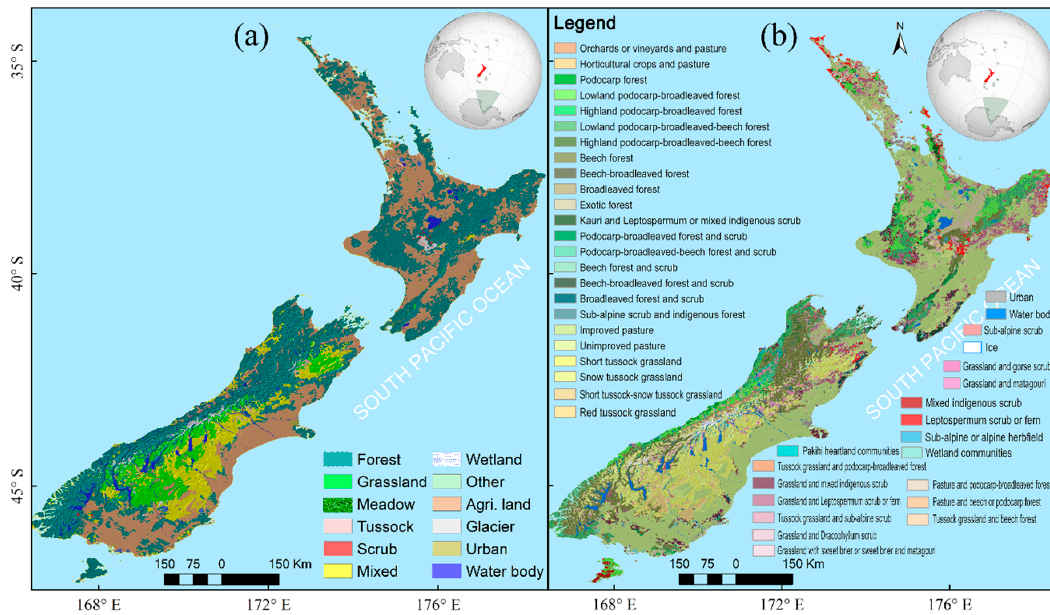
Figure 6. Vegetation maps of ( a ) habitats, and ( b ) vegetation classes of NZ.